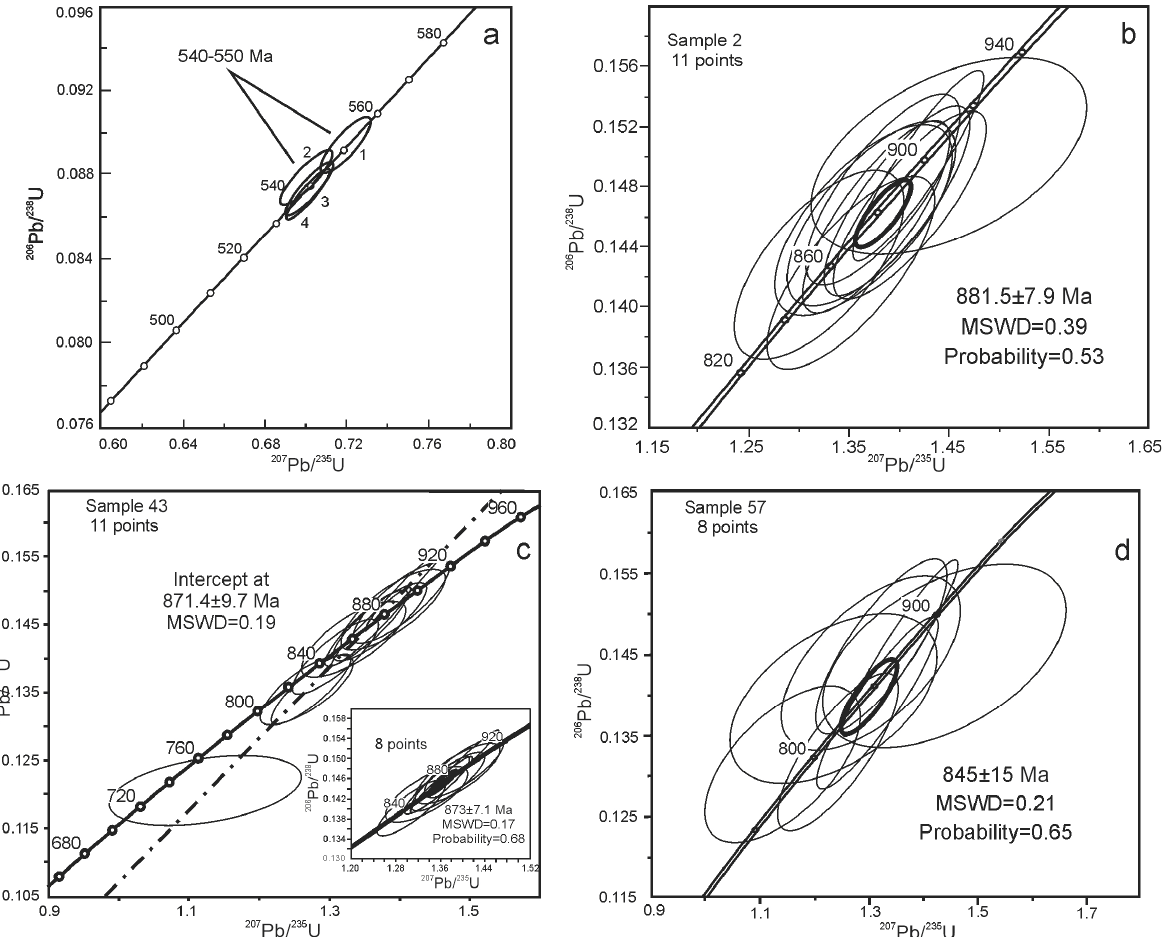
Figure 25. Concordia diagram for zircons ( a ) from sample 400 of leucogranites of Osinovka massif and ( b ) from the porphyroblastic plagiogneisses, ( c ) from rapakivi-type granites, and ( d ) migmatites of the Garevka Complex.